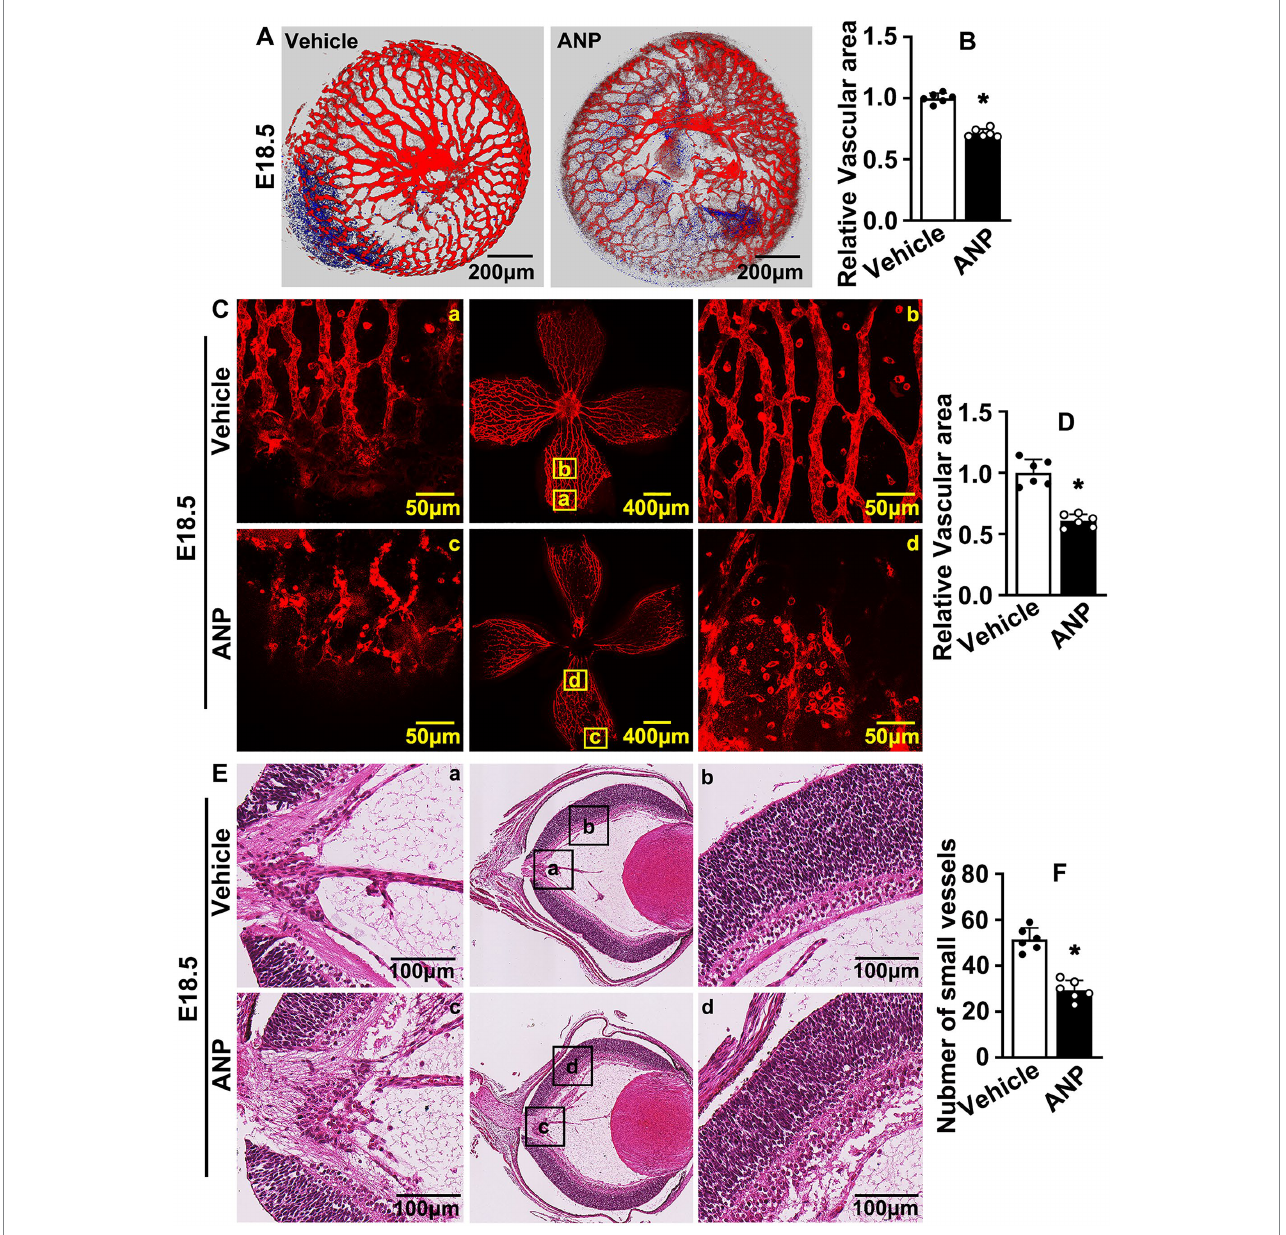
FIGURE 1 Andrographolide suppresses murine embryonic hyaloid vasculature development. (A) The E10.5 pregnant mice were administrated andrographolide (10 mg/kg) at noon everyday via consecutive intraperitoneal injection. Pregnant mice were sacrificed at E18.5. Retinas and crystalline lenses were isolated under microscope. Representative images of crystalline lenses at E18.5 with isolectin B4 (IB4) staining. Images were captured by 3D image stacks using confocal microscopy. (B) The quantification of the relative vascular area within crystalline lens at E18.5 ( n = 6). (C) Representative images of retinas at E18.5 with IB4 staining. Whole images were exhibited in the middle sites and the high resolution images of the corresponding areas were displayed on both sides. (D) The quantification of relative vascular area of retinas at E18.5 ( n = 6). (E) Representative images of H&E staining of eyeballs of E18.5 mice to exhibit hyaloid vascular vessels. Whole images were exhibited in the middle sites and the high resolution images of the corresponding areas were displayed on both sides. (F) Quantitative number of hyaloid vascular vessels at E18.5 ( n = 6). Quantitative data are presented as mean ± SEM, * p <